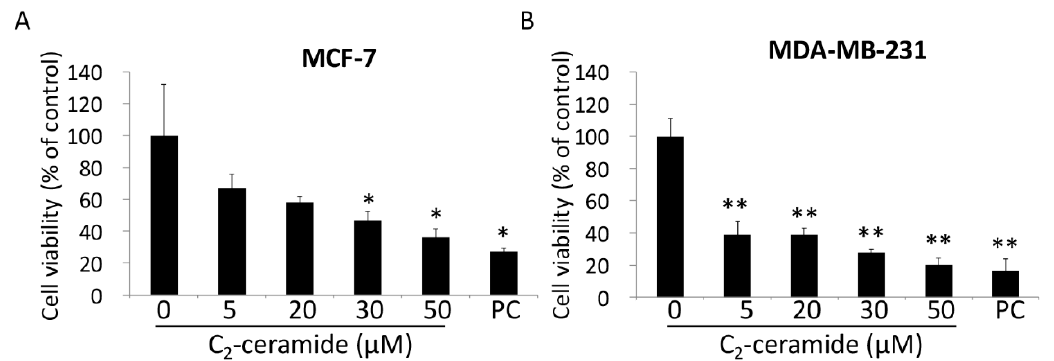
Figure 1. The inhibitory effect of C 2 -ceramide on breast cancer cells. Two breast cancer cell lines MCF-7 ( A ) and MDA-MB-231 ( B ) were treated with the indicated concentrations (from 5 to 50 µ M) of C 2 -ceramide for 24 h respectively. The cell proliferation was determined using the PreMix WST-1 assay. Nought indicates the cells were treated with C 2 -ceramide-free solvent as vehicle control. Positive Control (PC): 0.5 µM 2,9-Bis [2-(pyrrolidin-1-yl) ethoxy]-6-{4-[2-(pyrrolidin-1-yl) ethoxy] phenyl}-11H-indeno [1,2-c] quinolin-11-one (BPIQ), a camptothecin analog. * p < 0.05 and ** p < 0.001 for C 2 -ceramide versus control respectively.